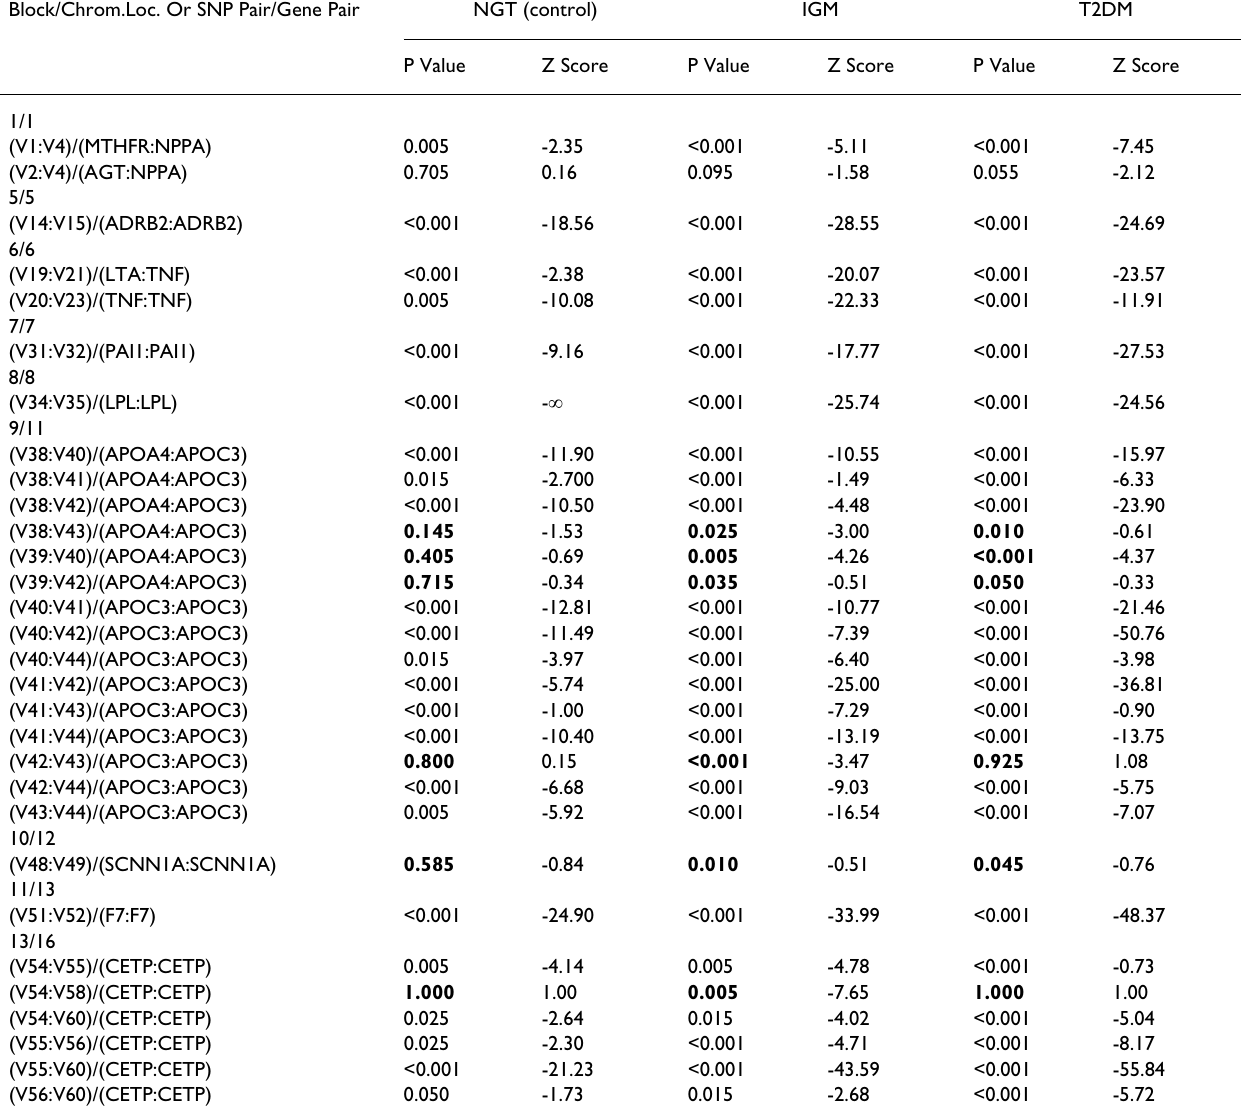
Table 5: Haplotype Interactions within Blocks, i.e. interactions between polymorphisms that are located on one chromosome. Hence substantially more polymorphisms are in complete association than in Table 4. Significant up- or down interaction is indicated with bold typeface. Block/Chrom.Loc. Or SNP Pair/Gene